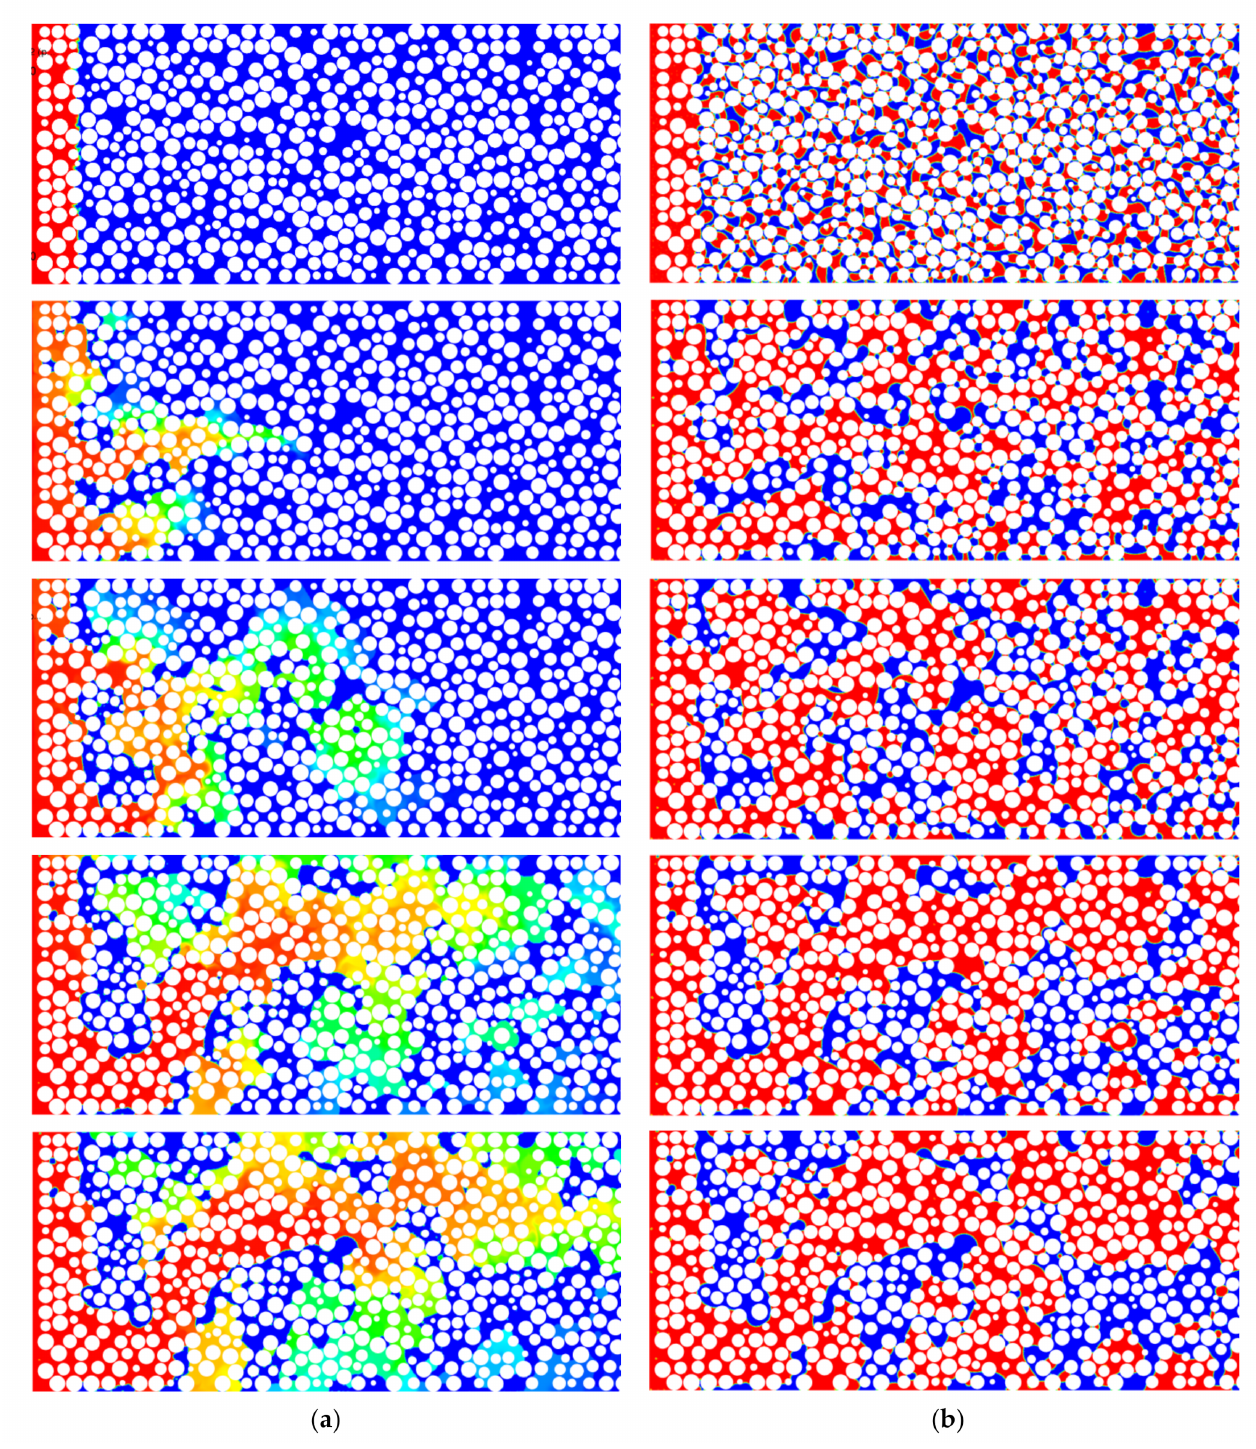
Figure 4. The concentration of nanoparticles ( a ) and oil distribution ( b ) in the process of displacement by nanofluid, ϕ = 1 wt% and Sw =